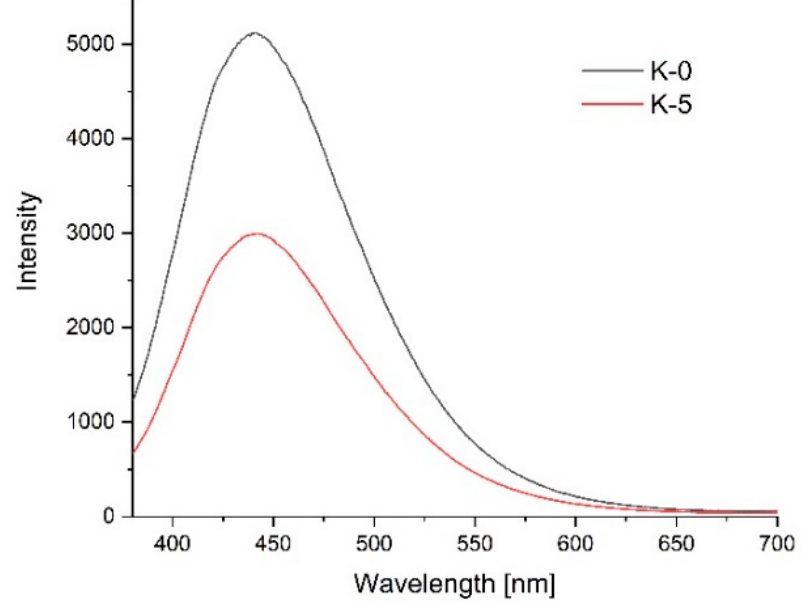
Figure 11. Emission lines of the control film before poultry meat storage (black line) and after 3 days of storage (red line).